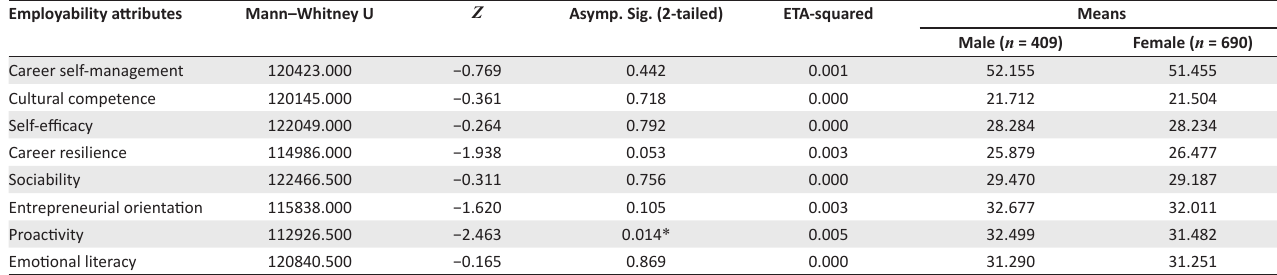
TABLE 2: Differences in employability attributes with regard to gender. Employability